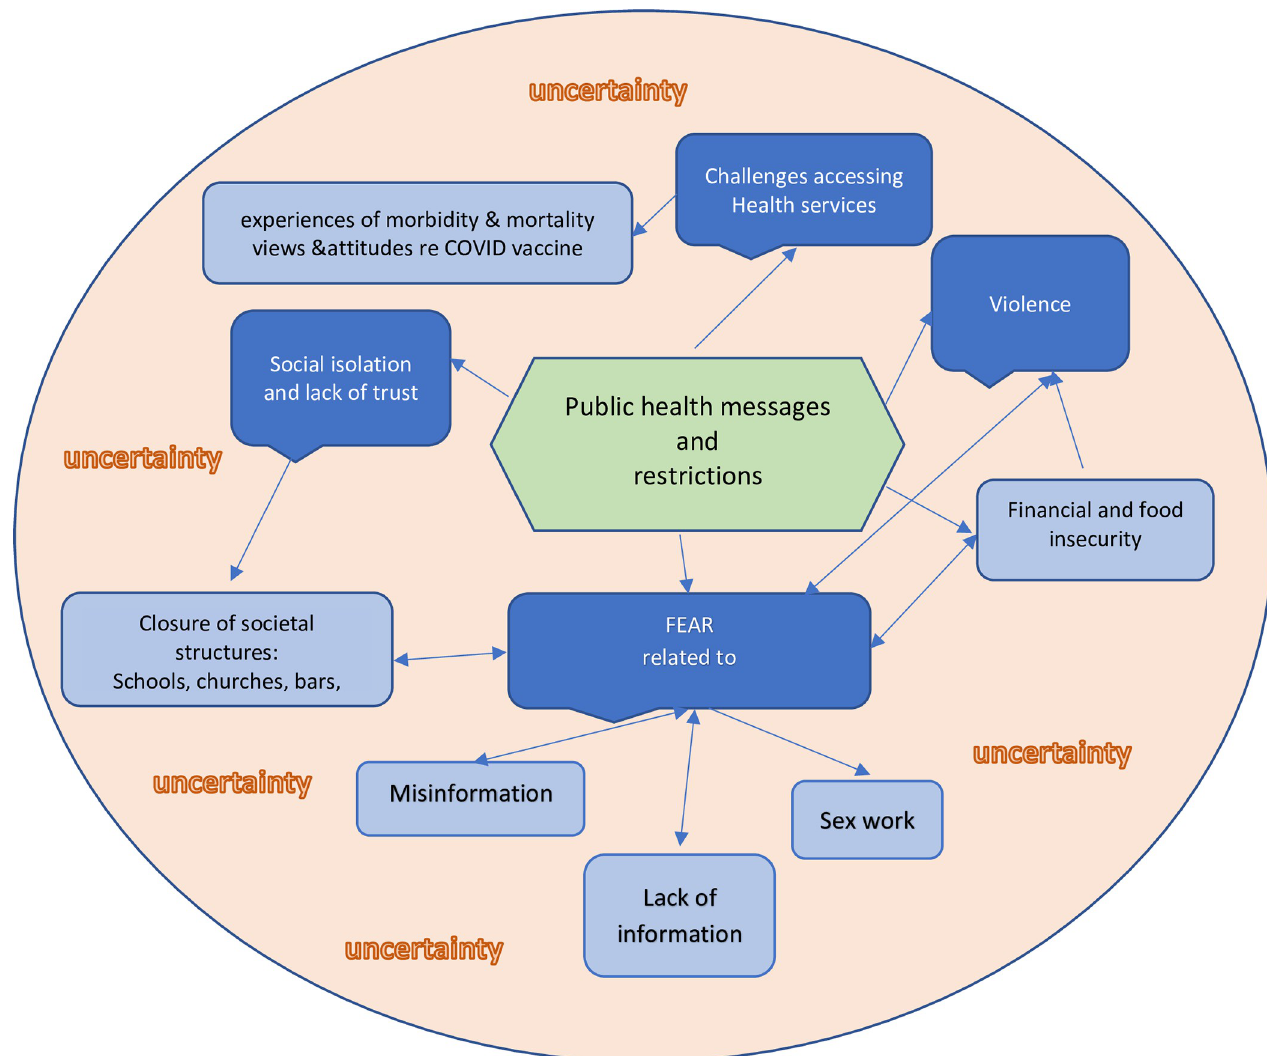
Fig 2. Themes related to public health messages and restrictions; Kampala 2020–2022.